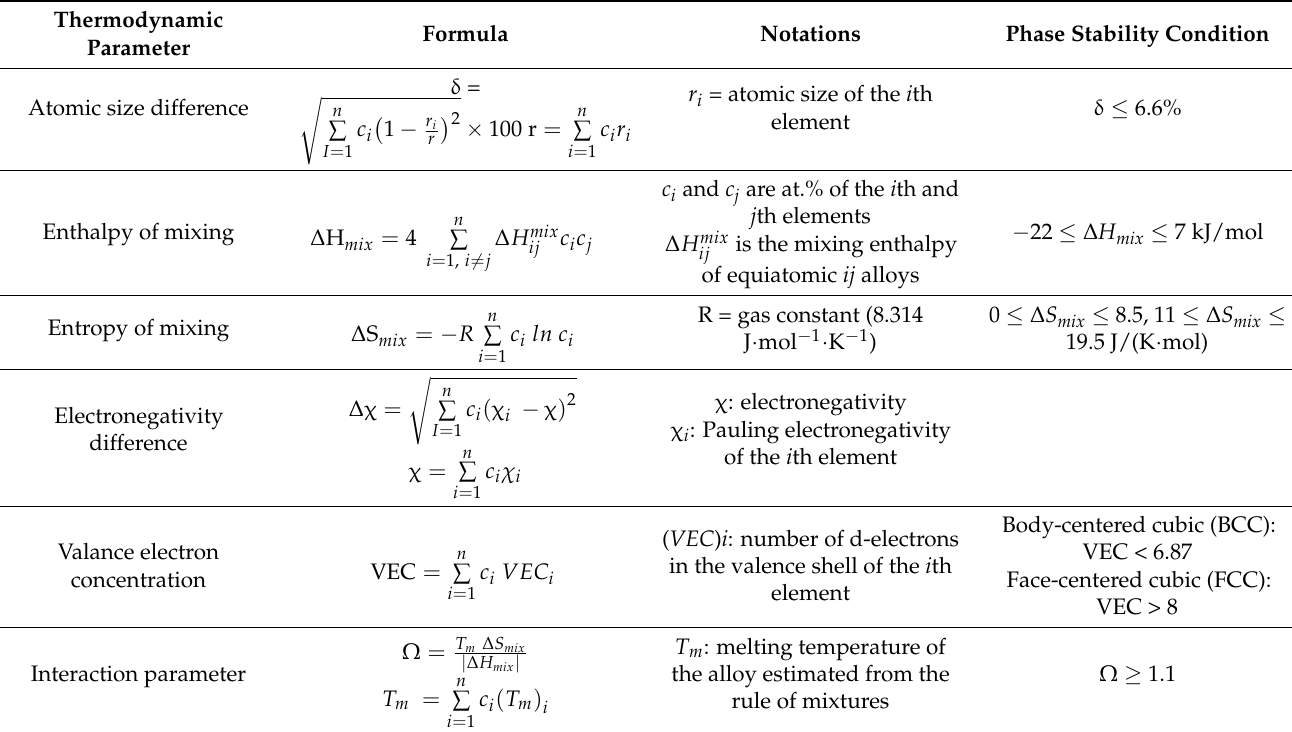
Table 4. Thermodynamic parameters for predicting solid solution phases in HEAs [145–147].